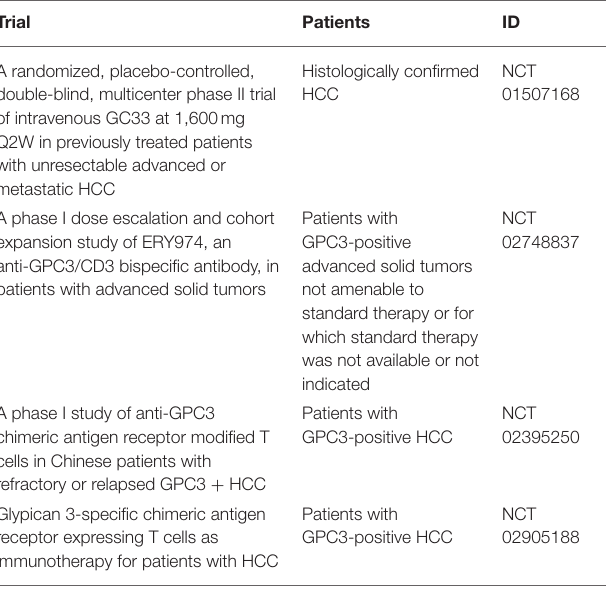
TABLE 2 | Summary of clinical trials for cancer immunotherapy targeting